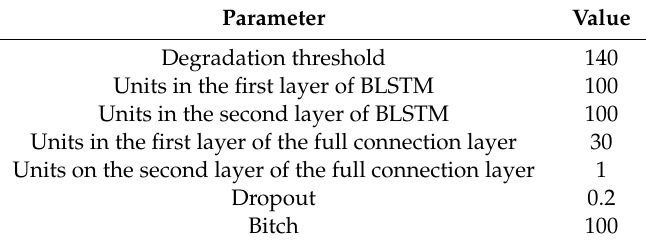
Table 3. Parameter setting of PCA–BLSTM hybrid model.